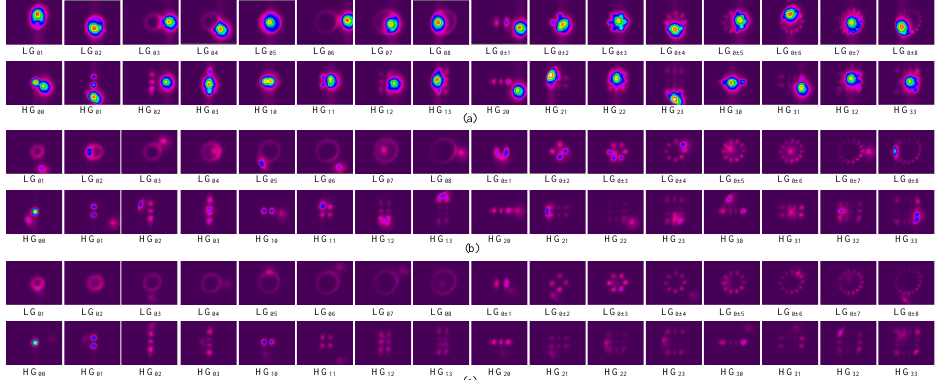
Figure 4. Measured beam profiles of left-hand DoA jammer at SJRs of ( a ) − 5 dB, ( b ) 0 dB, and ( c ) 3